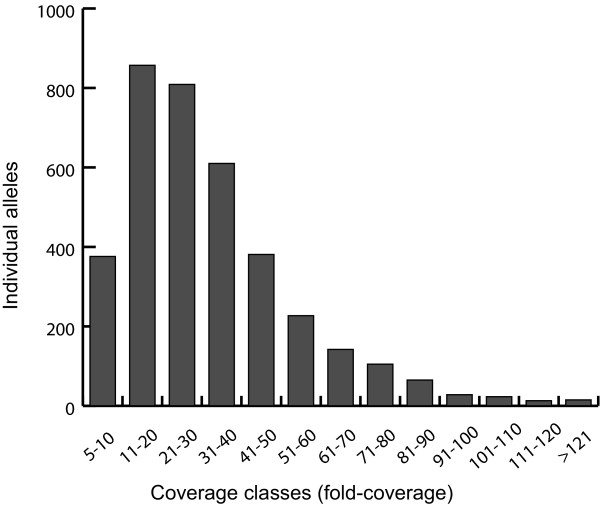
Allelic coverage distribution. Number of alleles found in different classes of fold coverage is displayed.